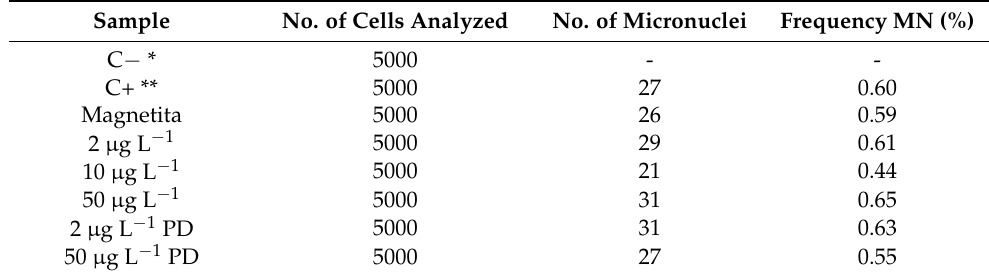
Figure 7. Light microscope photomicrographs of micronuclei analyzed in mitotic phases: ( A ) MN in interphase and ( B ) MN in prophase. Table 7. Results of micronuclei found in analyses.